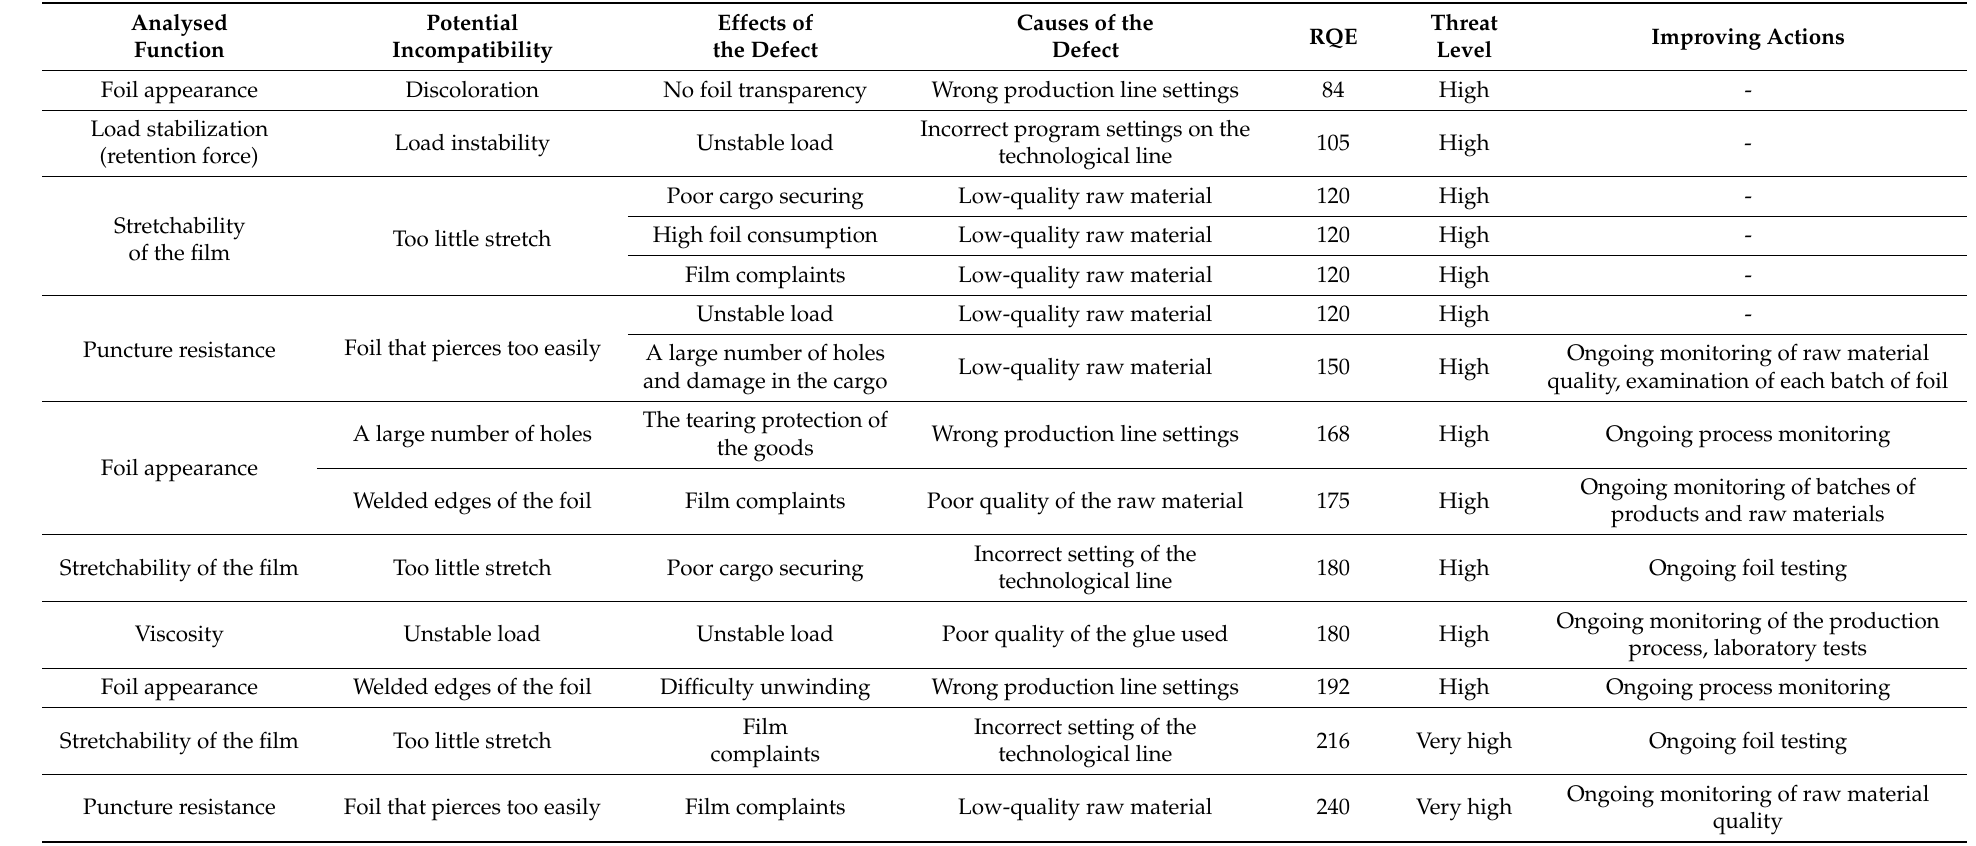
Table 12. Analysis of risk for the production process of five-layer stretch film for manual